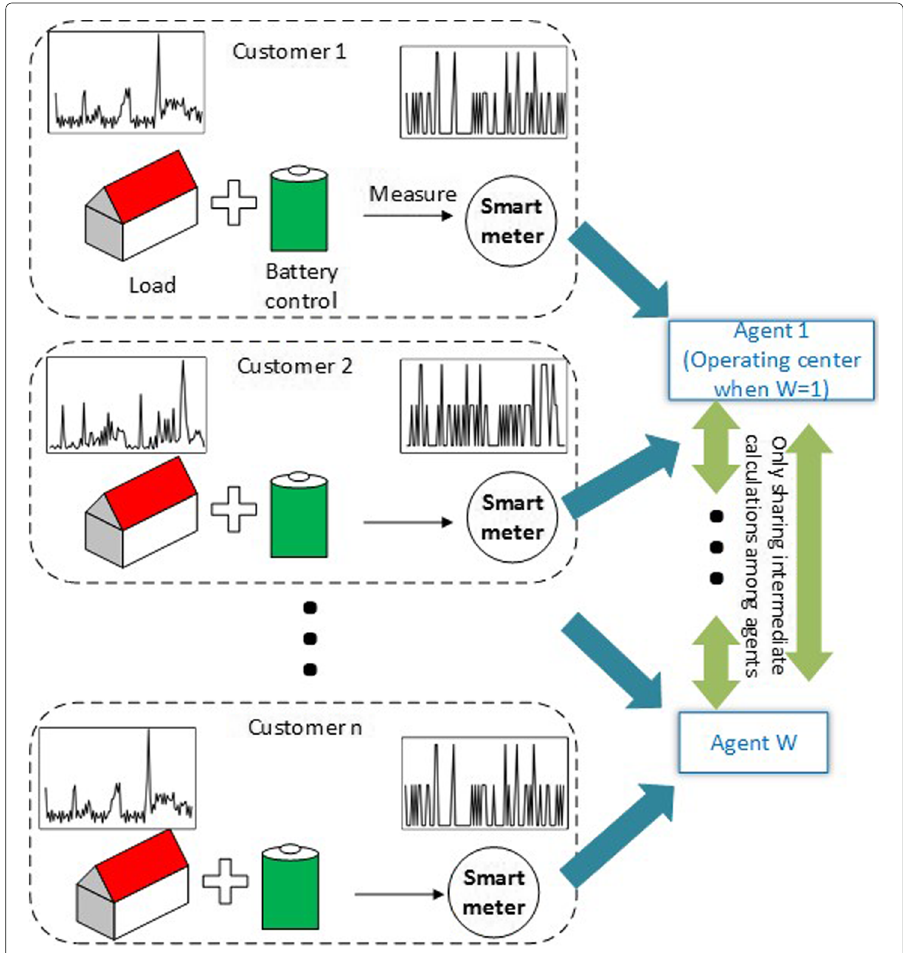
Fig. 1 The process of the quantization, measurement, collection, and